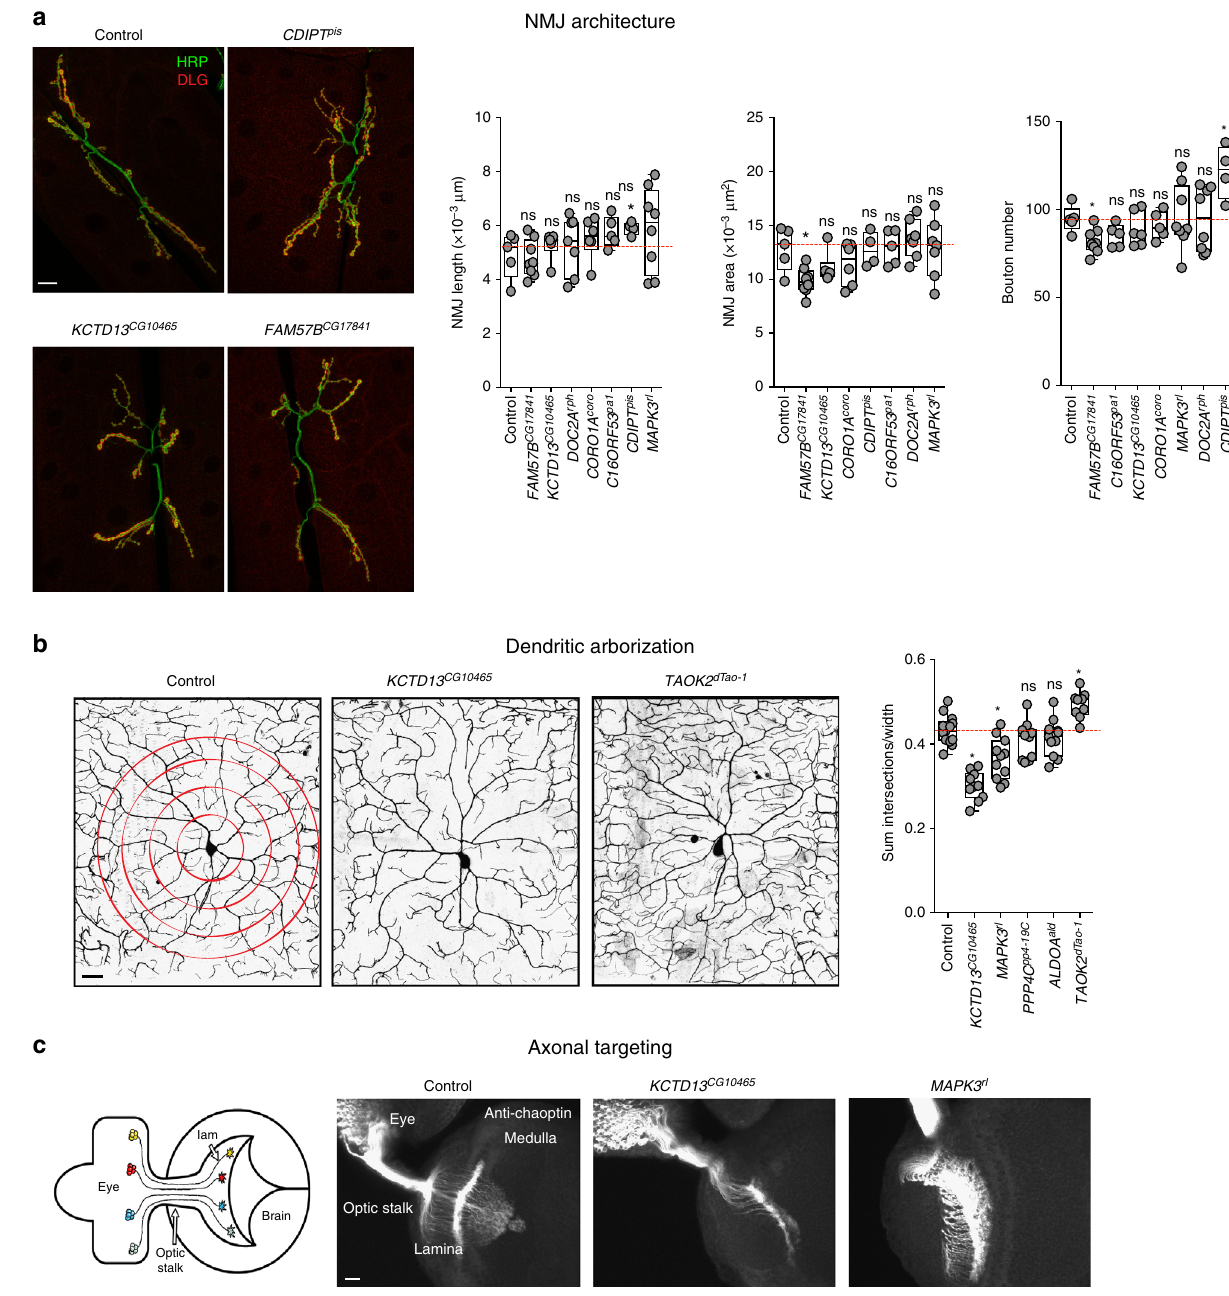
Fig. 3 Neuronal phenotypes of fl ies with knockdown of individual 16p11.2 homologs. a Assessment of neuromuscular junction length, synaptic area, and bouton numbers for the tested 16p11.2 homologs ( n = 4 – 8, * p < 0.05, Mann – Whitney test). Representative confocal fl uorescent images (maximum projections of two or three optical sections) of the larval neuromuscular synapses are shown for three homologs (scale bar = 20 µ m). b Assessment of dendritic arborization in larvae with knockdown of 16p11.2 homologs, including a box plot of the total number of intersections for all analyzed homologs, calculated by manual Sholl analysis and normalized to width measurement for each given hemisegment to control for slight size variation ( n = 9 – 11, * p < 0.05, Mann – Whitney test). Representative confocal live images of class IV da neurons labeled with mCD8-GFP under the control of ppk - GAL4 are shown for two 16p11.2 homologs and control (scale bar = 25 µ m). c Assessment of axonal targeting with knockdown of 16p11.2 homologs. The schematic of the third-instar larval visual system was generated by Sam Kunes 68 and reprinted with permission from the publisher. Representative confocal images of larval eye discs stained with anti-chaoptin illustrate normal axonal targeting from the retina to the optic lobes of the brain in the control and defects with eye-speci fi c knockdown of KCTD13 CG10465 and MAPK3 rl (scale bar = 10 µ m). All boxplots indicate median (center line), 25th and 75th percentiles (bounds of box), and minimum and maximum